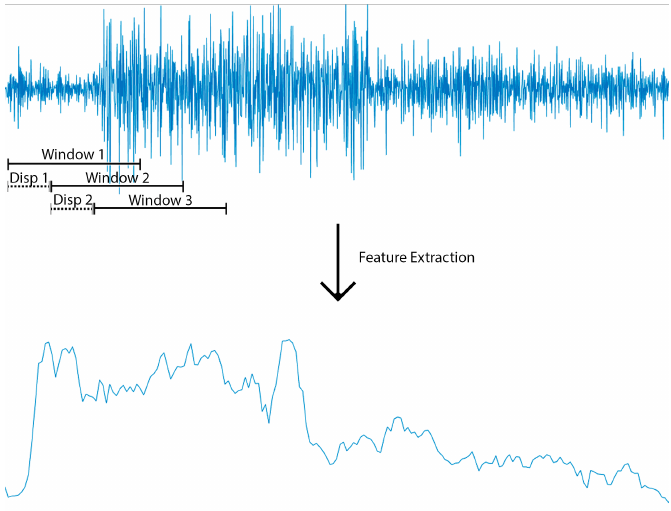
Figure 2. Outline representing the process of feature extraction. The upper plot represents EMG raw data from which only a portion is processed at each time step. The currently processed portion, named window, is displaced in time each iteration with a defined step-size (Disp 1 for the first iteration, Disp 2 for the second). This example uses an overlapping scheme where consecutive windows overlap in order to compensate the data acquisition delay and smooth the feature vector. The data in the window is updated to the most recent data recorded. Features (the root mean square RMS) are constantly extracted from the current window at each time step. The lower plot corresponds to the extracted features of the data. (Neither window nor displacement sizes exemplify actual dimension, but had to be enlarged for visual